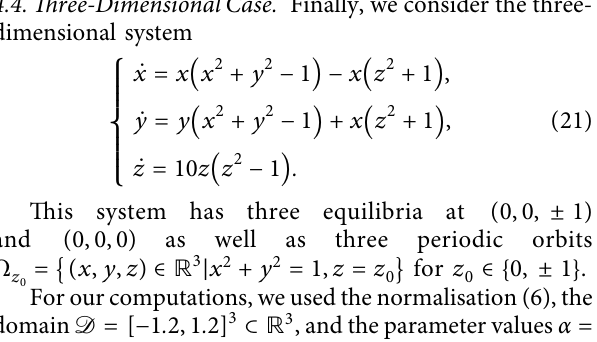
Figure 3: System (18). (a) The overestimation of the chain recurrent set 􏽥 X 0 � C (c) The refined approximation with our new method 􏽥 X 0 of the chain recurrent set. (d) Comparison between the overestimated chain recurrent set (in black) and the reduced chain recurrent set (green) in a zoomed